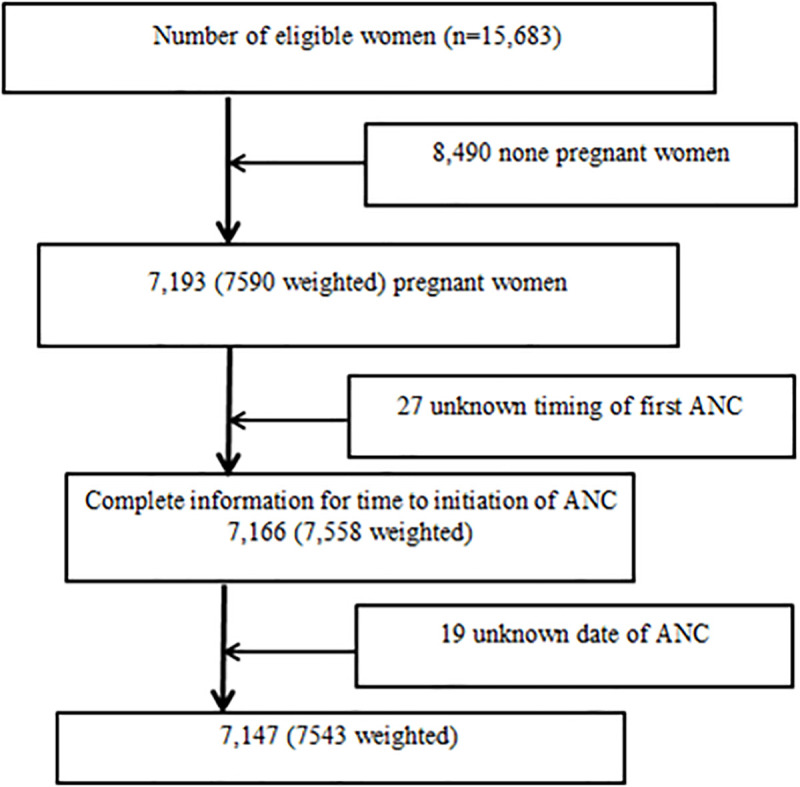
Sample size and sampling procedure to reach the final sample size in 2016 EDHS.